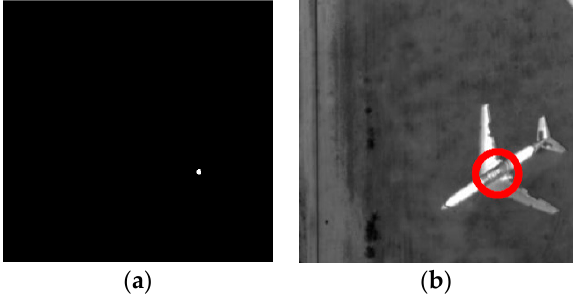
Figure 3. The result graph after circle frequency filtering; ( a ) Threshold segmentation map; ( b ) Circles with radii of the circumference centered on the points in ( a ) is marked on the original image.